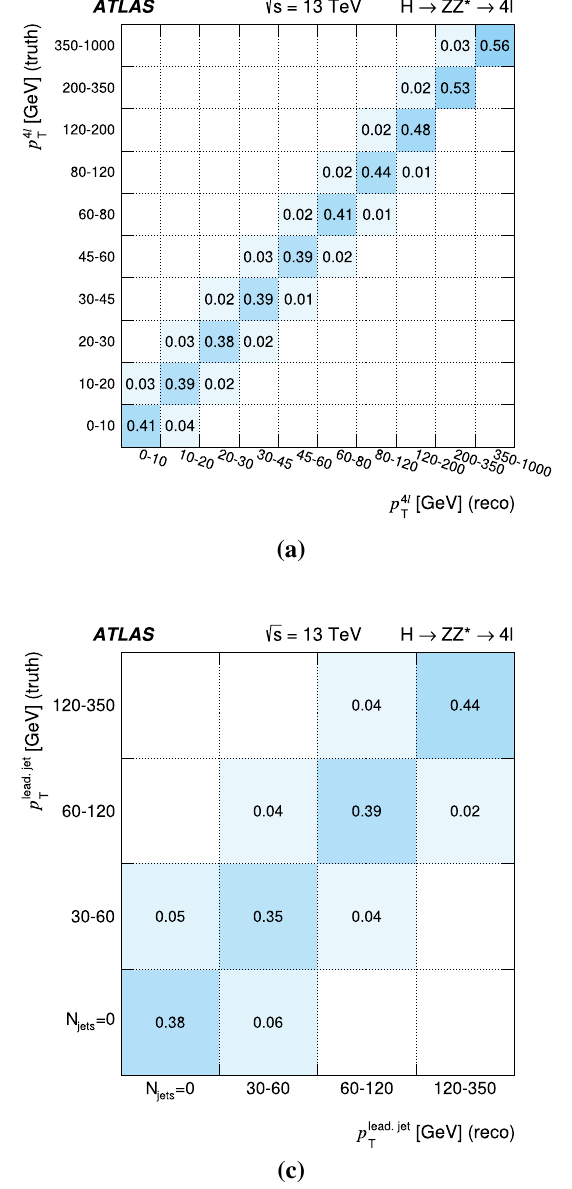
Fig. 1 Response matrices, derived using simulation, for a the trans- verse momentum of the four-lepton system p 4 (cid:3) N jets , c the transverse momentum of the leading jet p lead